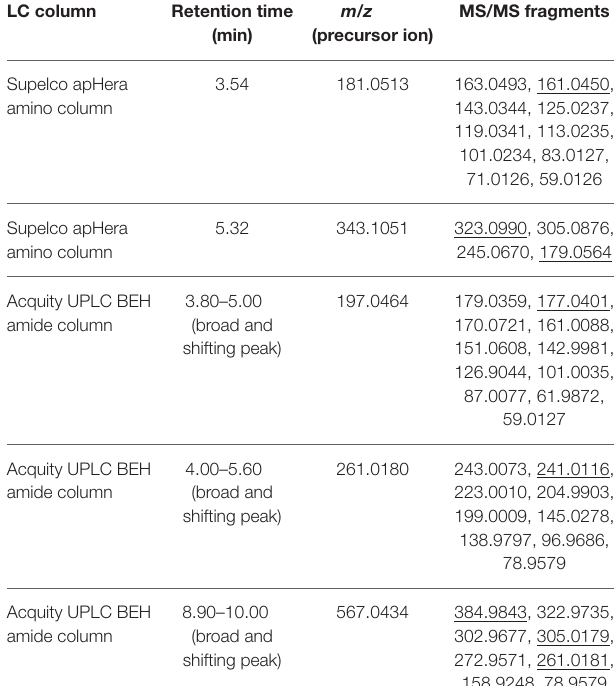
TABLE 1 | List of precursor ions which gave rise to fragment ions with HF or 19 FDG neutral losses upon fragmentation (underlined MS/MS fragment), their monoisotopic mass, retention time and MS/MS